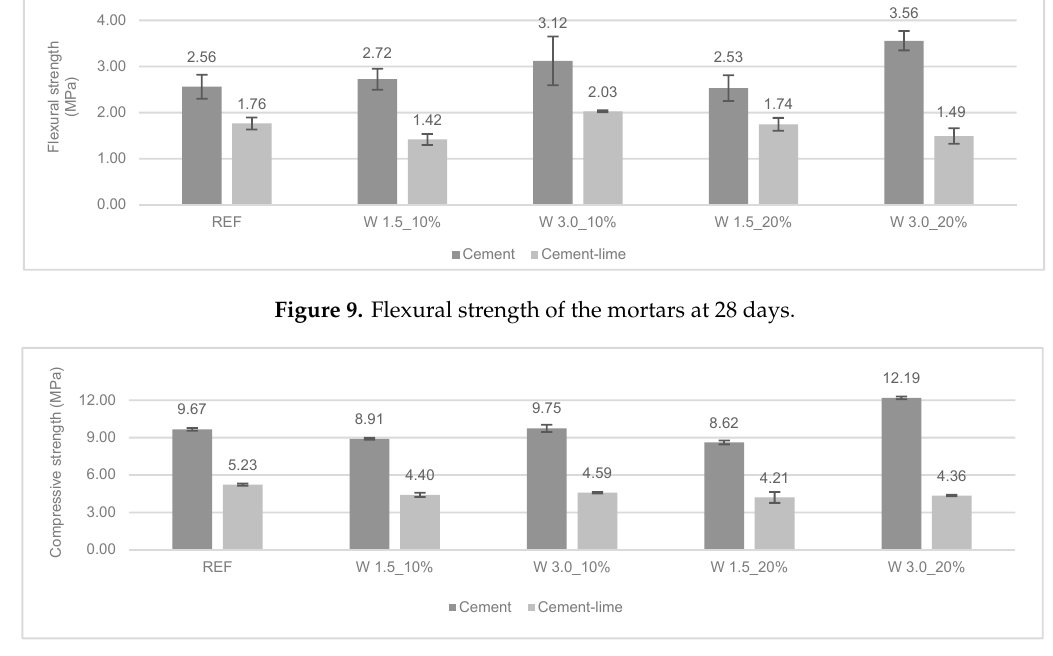
Figure 10. Compressive strength of the mortars at 28 days.